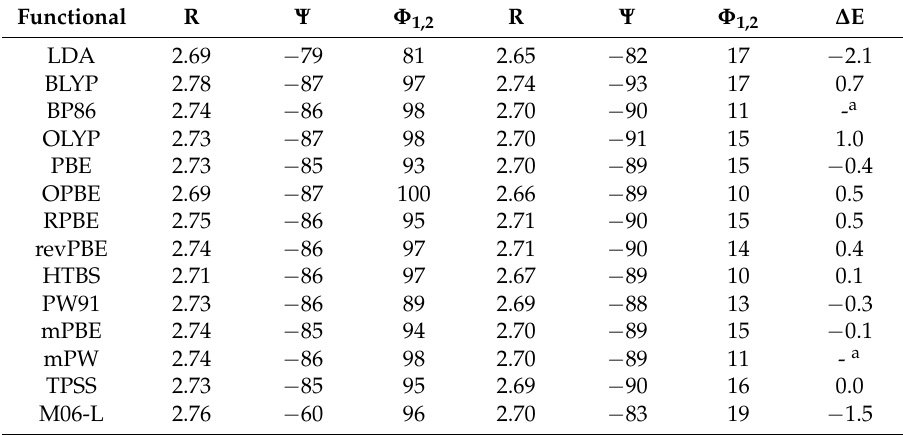
Table 1. Relative energies of Ph 2 Te 2 conformers (kcal mol − 1 ), Te–Te bond lengths (R, Å) and amplitudes of the Ψ and Φ 1,2 dihedral angles ( ◦ ) calculated with 23 different functionals combined with the TZ2P basis set; scalar ZORA effects were included in the calculations. Open conformer is taken as reference in the ∆ E